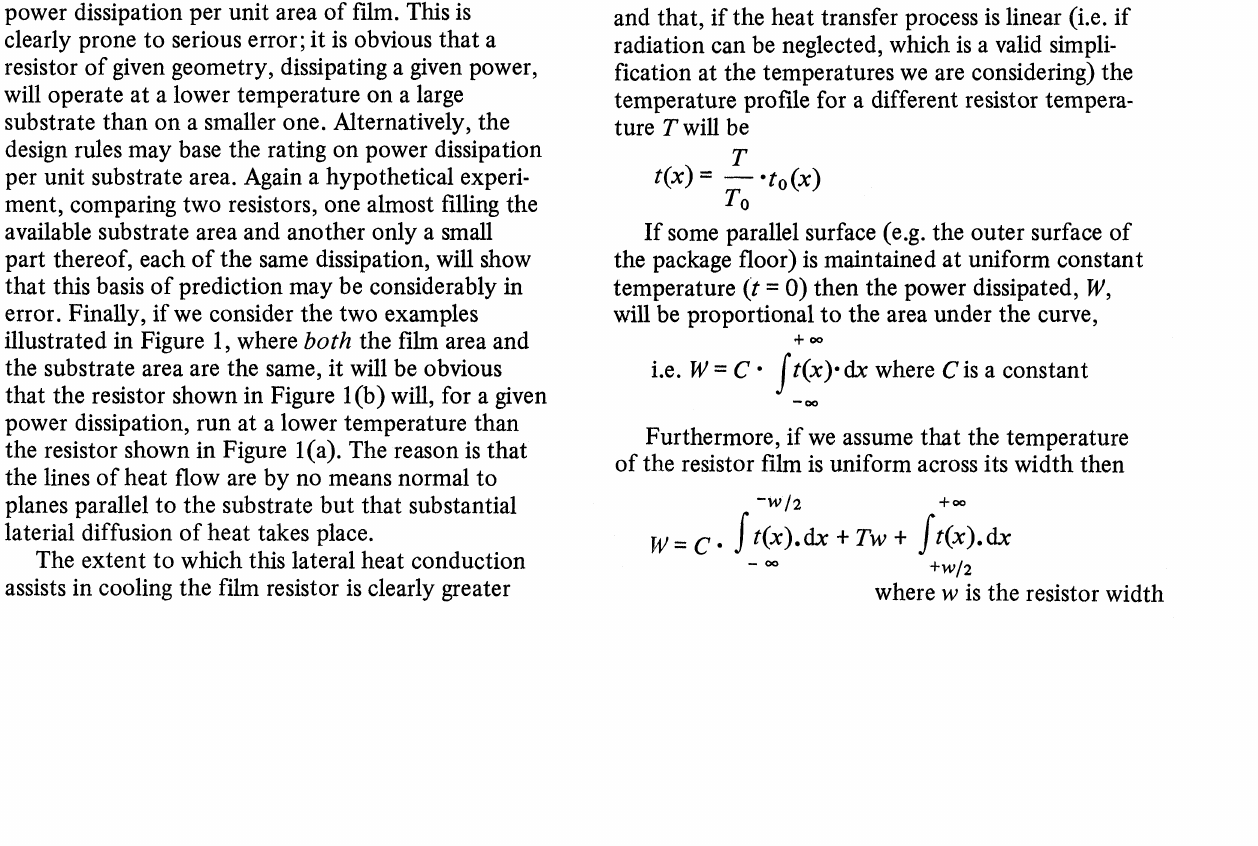
Film resistors where both the film area and the substrate area are the same. power dissipation of the resistors included in the layout.